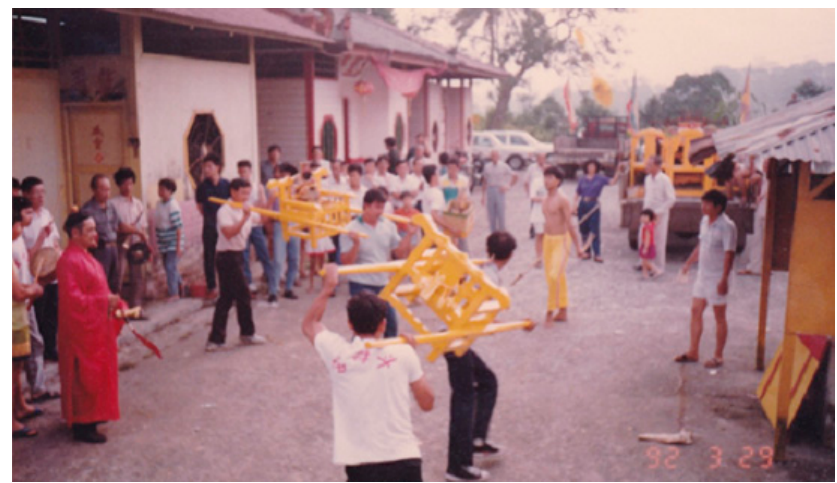
Figure 2. Celebration of the Nine Emperor Gods Festival at Outer Dong Cheng Village in 1992 4 .